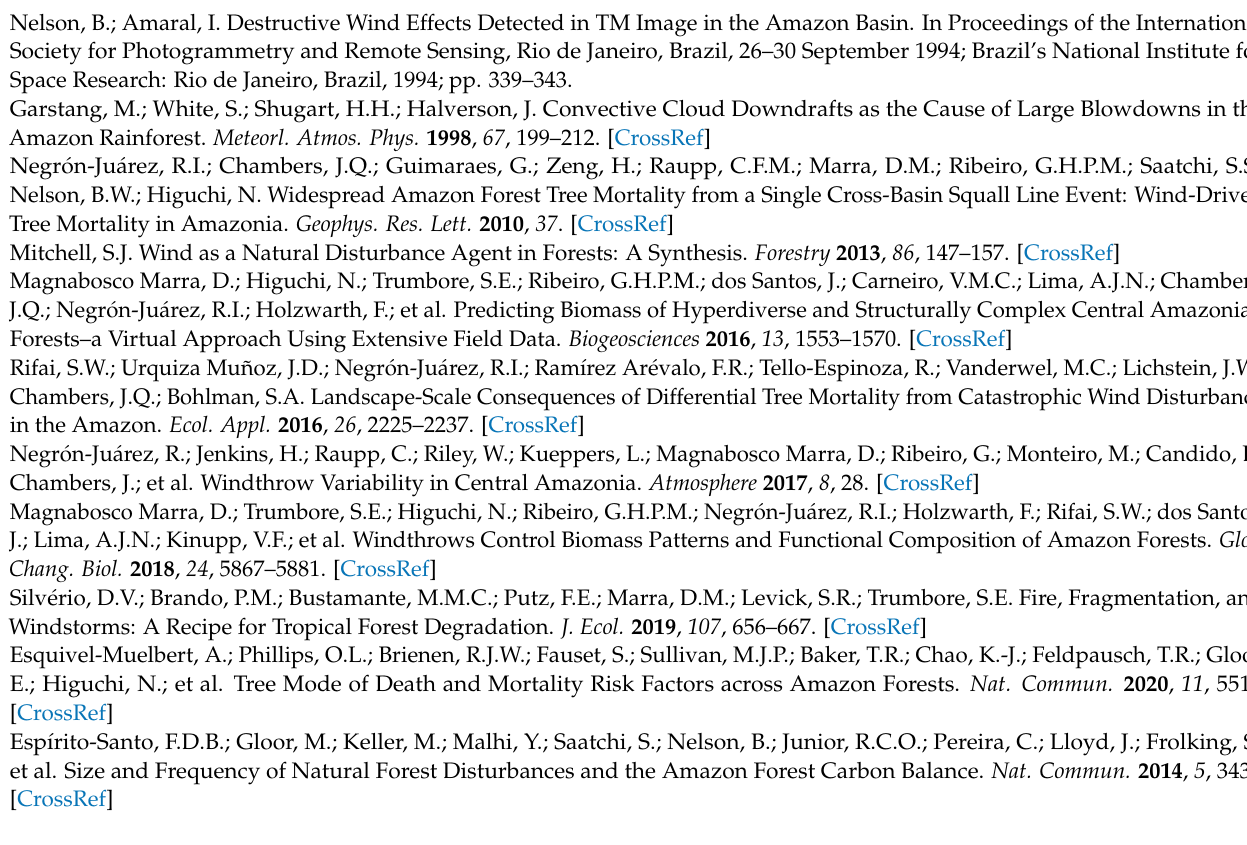
Figure A2. Recovery of AGB (Mg ha − 1 ) of old-growth and windthrown forests across the range of severity classes at 2, 12, and 22 years after windthrow. 95% confidence intervals given by the error bars. Dashed dark green lines show the old-growth mean (of the three sites).